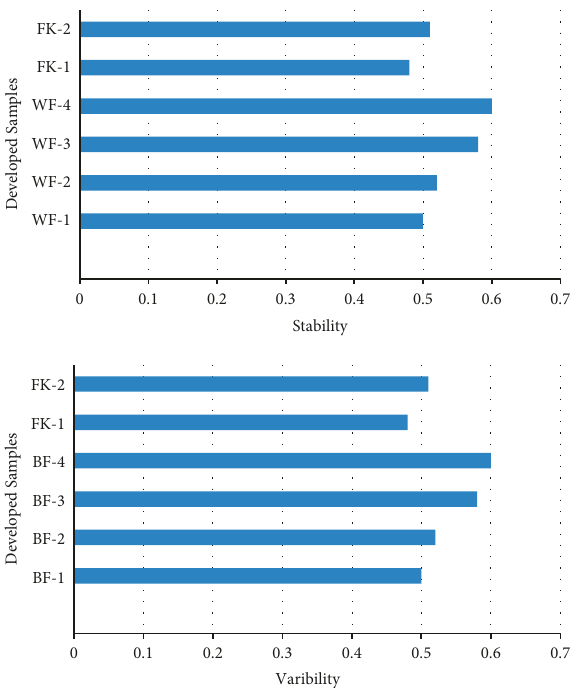
Figure 9: Stability and variability coefficient behaviour of devel- oped